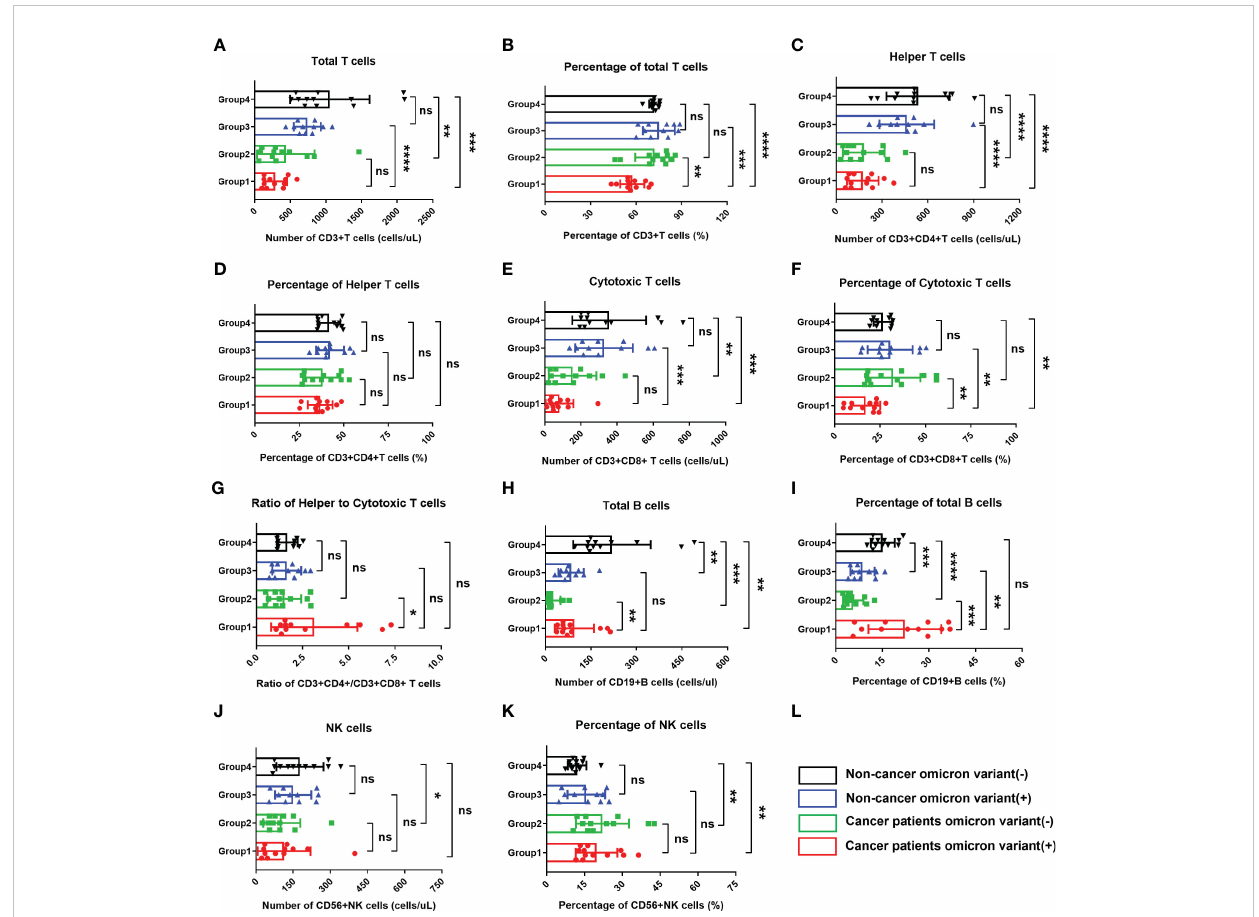
FIGURE 2 Comparisons of lymphocyte subsets in four groups of participants. The comparisons of count of total T cells in four groups during clinical observation (A) , percentage of total T cells (B) , count of helper T lymphocytes (C) , percentage of helper T lymphocytes (D) , count of cytotoxic T cells (E) , percentage of cytotoxic T cells (F) , ratio of helper to cytotoxic T lymphocytes (G) , count of total B cells (H) , percentage of total B cells (I) , count of NK cells (J) , percentage of NK cells (K) . (L) Black, non-cancer omicron variant ( − ); Blue, non-cancer omicron variant (+); Green, cancer patients omicron variant ( − ); Red, cancer patients omicron variant (+). Points in each bar represent 4 subjects ’ data from different time points. ns, not statistically signi fi cant. *p <0.05, **p <0.01, ***p <0.001, ****p